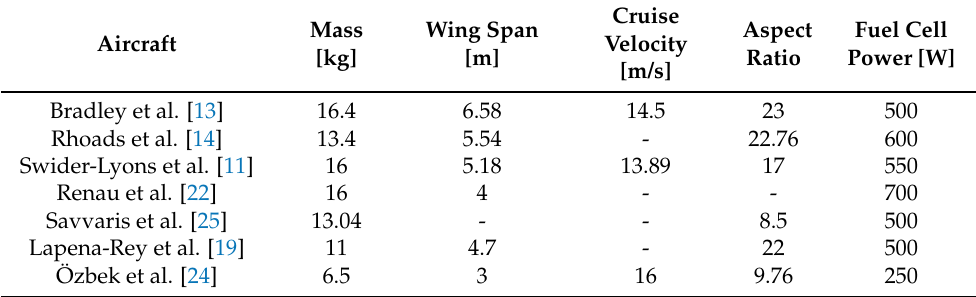
Table 1. Existing